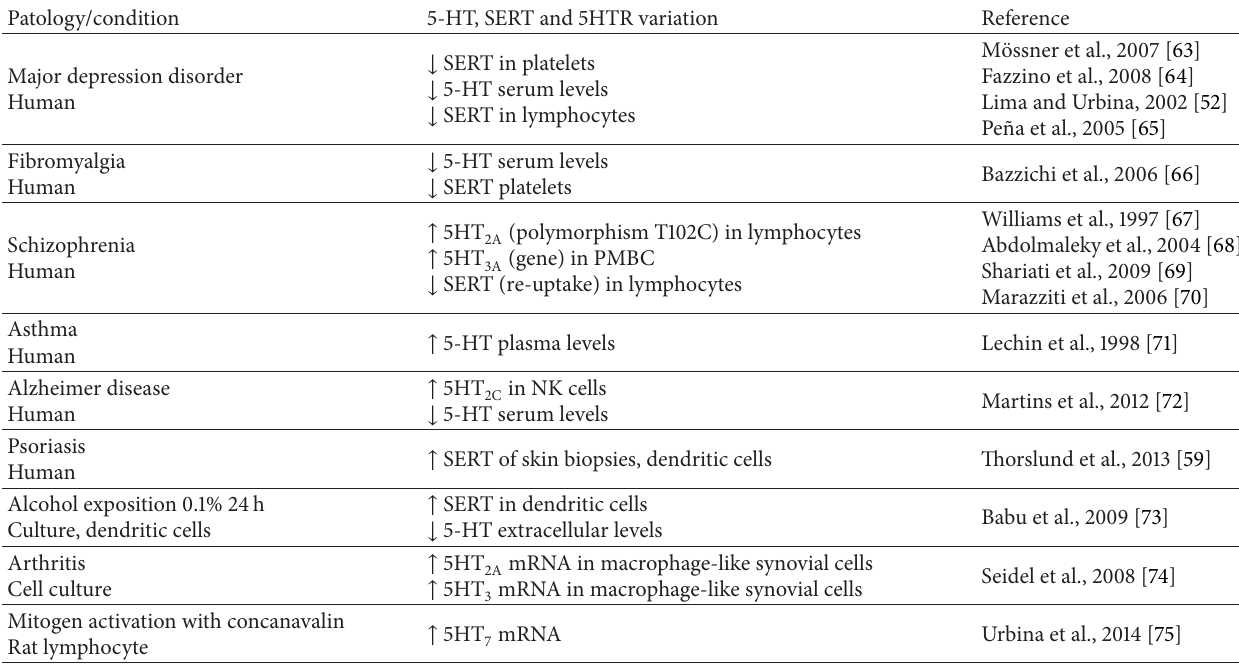
Table 3: Pathology-associated serotonergic protein expression in immune